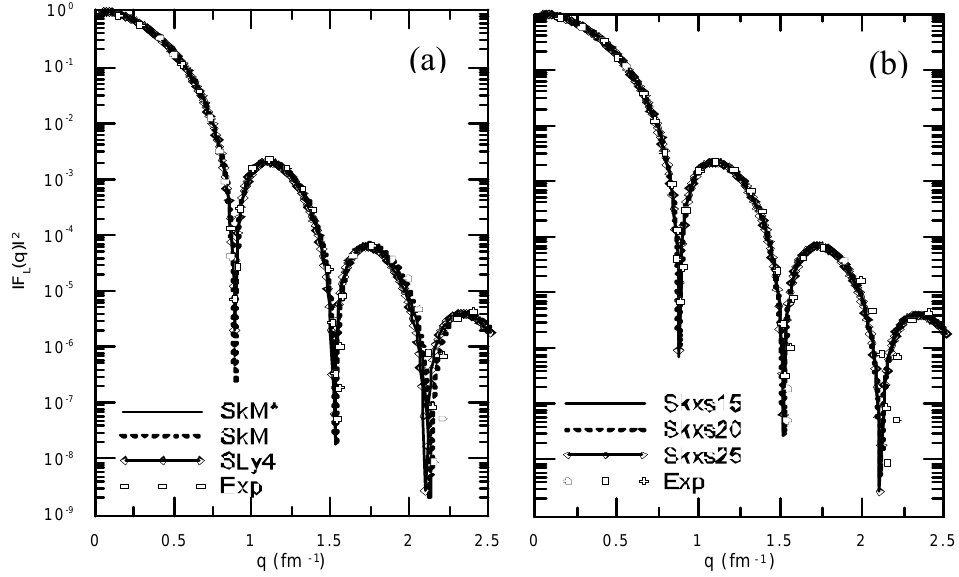
Fig. 7: The charge forms factor for 92 Mo versus momentum transfer q (fm -1 ) using different Skyrme